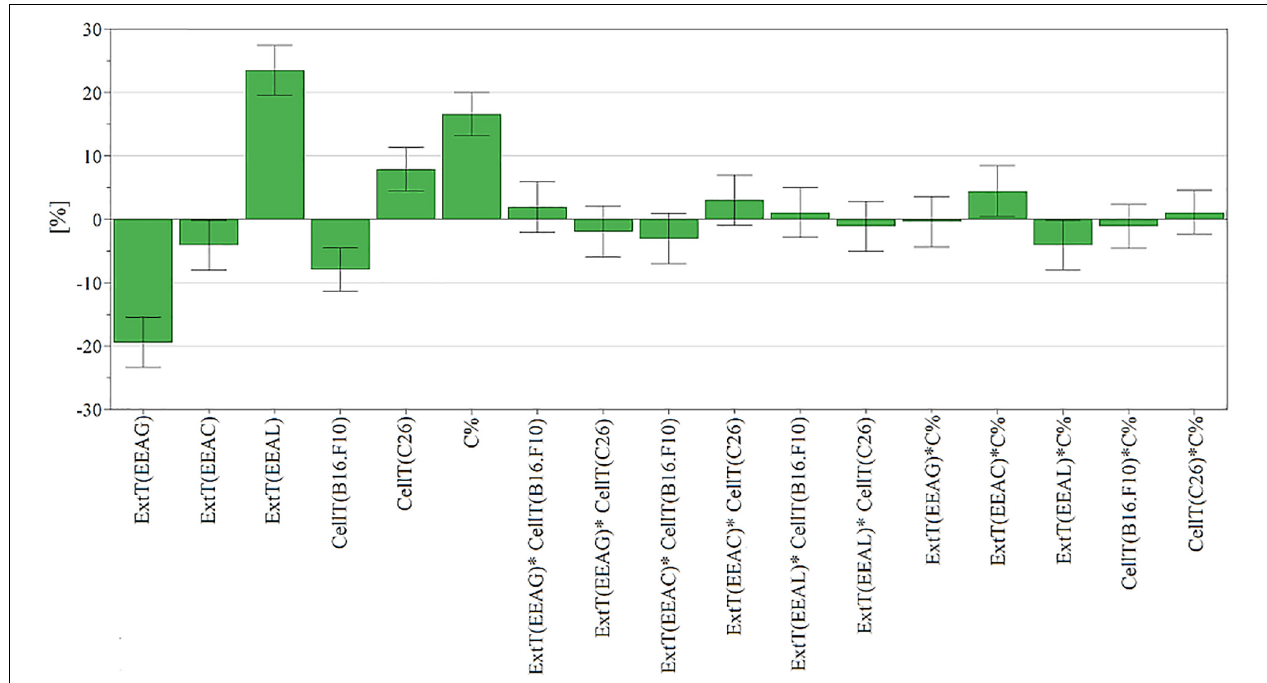
FIGURE 5 | Scaled and centered coefficient bar plot for cell proliferation inhibition. To analyze the effect of factors on cell proliferation inhibition, the coefficients of the polynomial equation were plotted. The coefficient of a factor represents the change in response induced by increasing the factor’s level from low to high while all other factors are at average level. Each coefficient has a 95% confidence interval, represented through error bars, and reflecting its uncertainty. EEAG, A. genevensis ethanolic extract; EEAC, A. chamaepitys ethanolic extract; EEAL, A. laxmannii ethanolic extract.